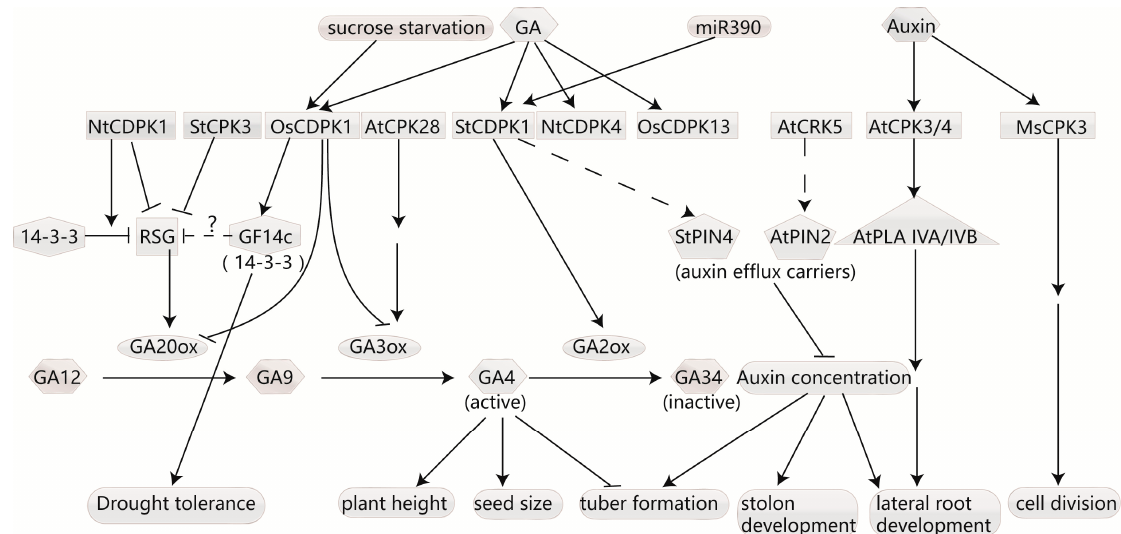
Figure 1. CDPKs in GA biosynthesis and auxin transport. Several CDPKs have been found to phosphorylate RSG, a basic leucine zipper (bZIP) transcriptional factor. RSG is suggested to contribute gibberellins (GA) feedback regulation by regulating transcription of genes encoding GA20ox. Additionally, the function of RSG is inhibited by binding 14-3-3 proteins to the phosphorylated sites. GA20ox and GA3ox catalyze the final steps to generate bioactive endogenous GAs while GA2ox is responsible for transferring active GAs to inactive GAs. Cellular transports of auxin are controlled by influx carriers such as the AUX/LAX influx and efflux carriers including PIN-FORMED (PIN) as well as the PGP/ABCB. Some CDPKs can phosphorylate auxin efflux carriers (PIN) to influence auxin concentration. GA and auxin affect many aspects of plants development. The dashed lines represent that there are only evidences in vitro. Question marks indicate that the relation is guessed. PLA, patatin-related phospholipase A. Arrows indicate promotion, and T bars indicate suppression.